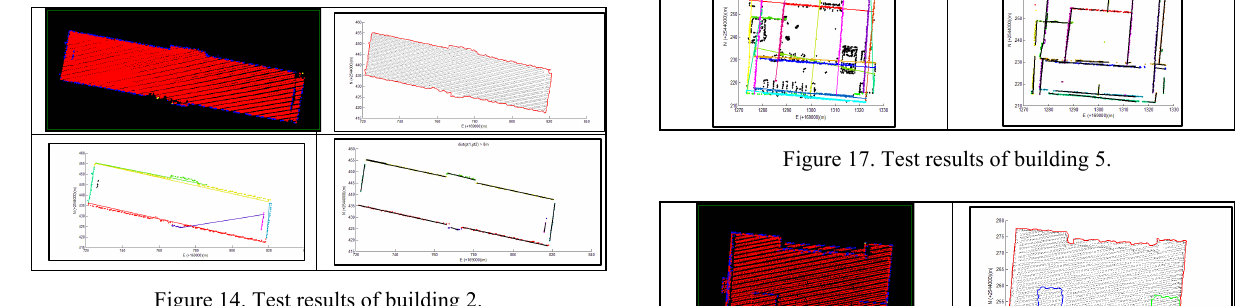
Figure 13. Test results of building 1.